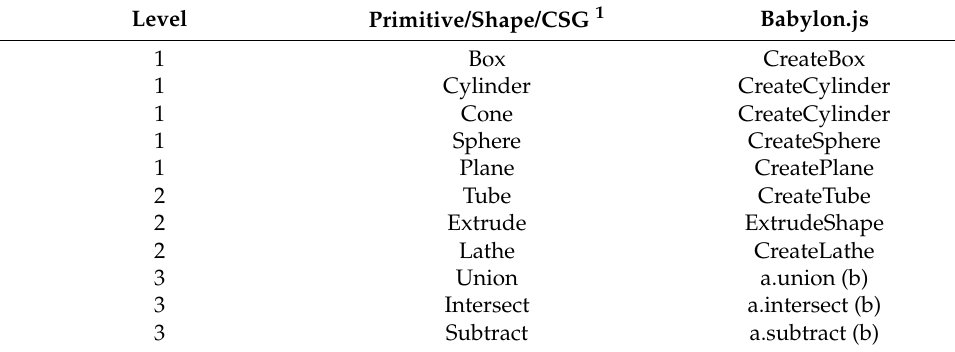
Figure 3. The 3DConversion method. Table 2. Mapping graphic commands.